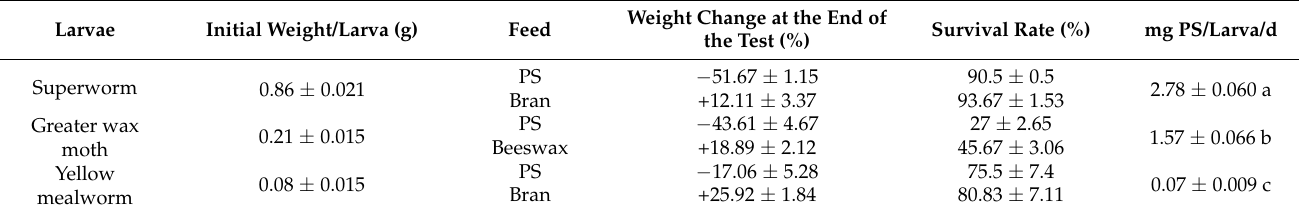
Table 1. Summary of PS biodegradation by the three species’